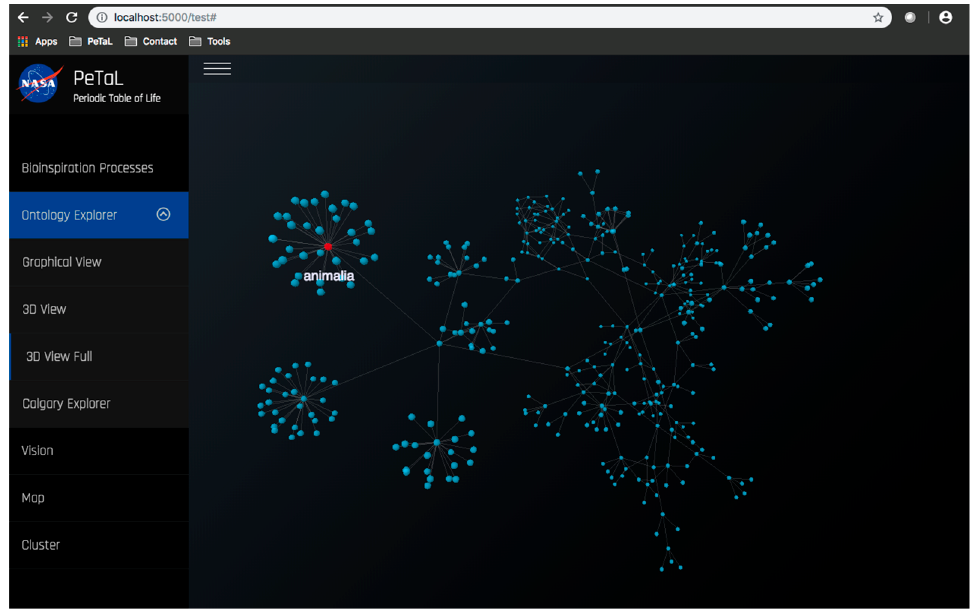
Figure 27. Ontology explorer in PeTaL showing data that is clustered by similarity in taxon. Clicking on nodes shows information regarding the node(s) such as in Figure 26.